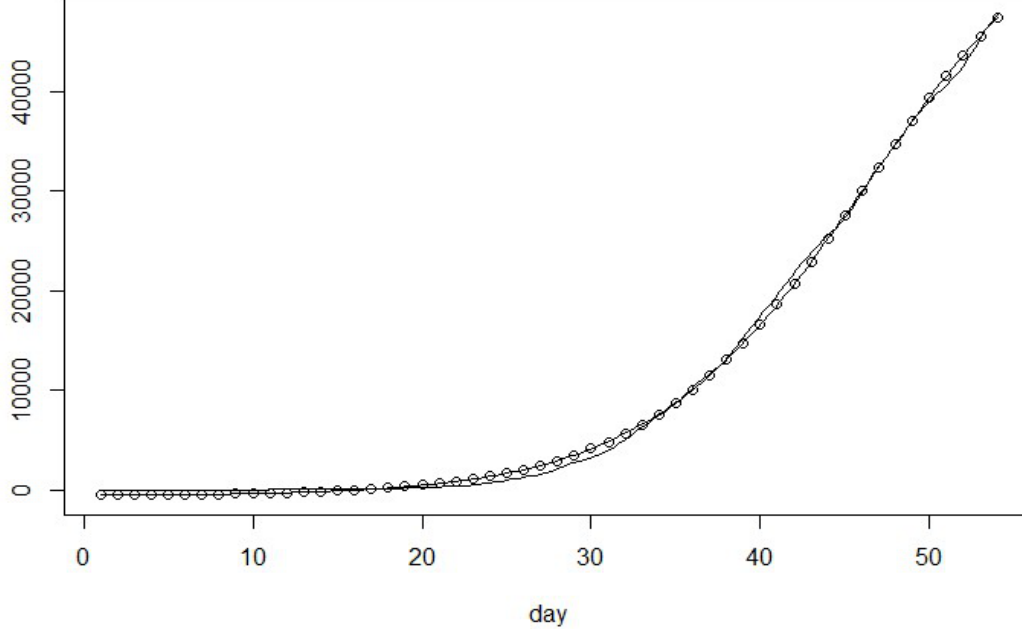
Figure 2. The estimated cumulative number of deaths vs. actual death data from Model 2.